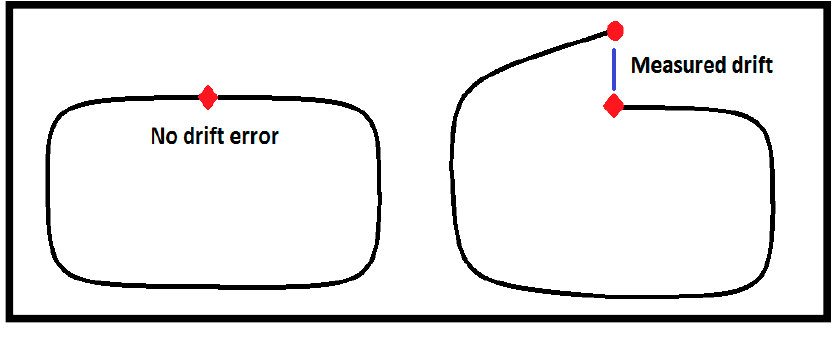
Figure 8. Measuring drift error in trajectories.